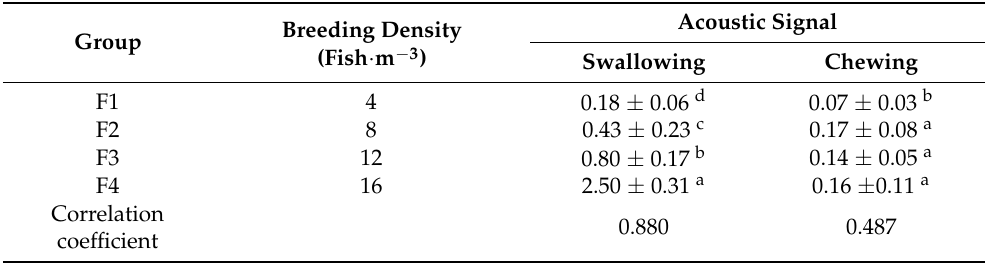
Table 3. Correlation analysis between short-term mean amplitude of feeding sound and breeding density of largemouth bass ( p <